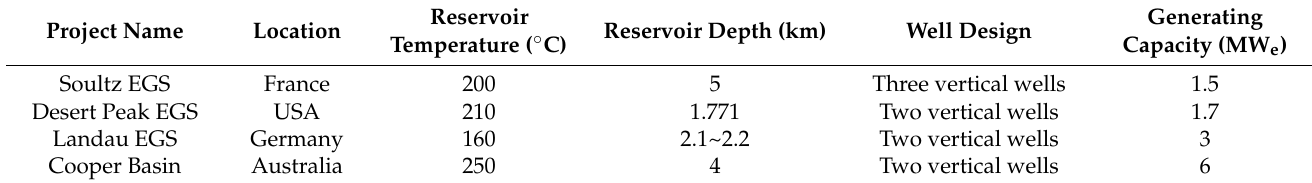
Table 1. Important ongoing EGS fields all over the world